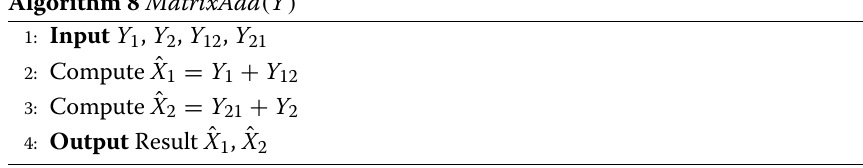
Algorithm 8 MatrixAdd ( Y )